Question: Write a single sentence explaining what this figure depicts.
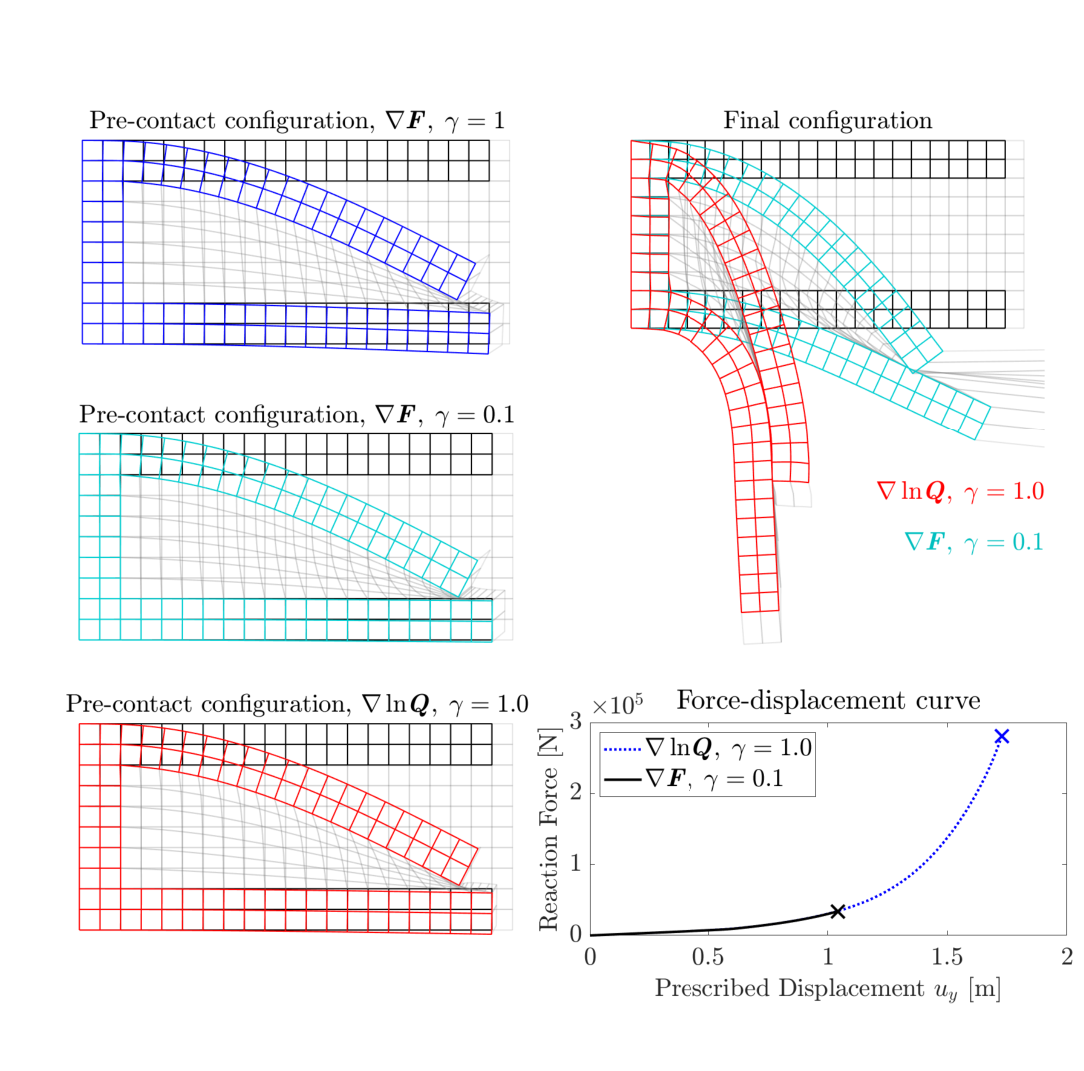
Answer: Self contact example and a comparison of the newly proposed regularization ∇ln Q to a ∇F formulation of Bluhm et al. [30]. In the pre-contact phase, ∇F with γ = 1 exhibits premature contact (in blue), unlike ∇ln Q (in red) or ∇F with γ = 0.1 (in cyan). The final configuration plot and its associated force-displacement curves with highlighted points of failure demonstrate the higher robustness of the ∇ln Q regularization. The ∇ln Q formulation only becomes numerically unstable when the contact surface starts being loaded in a tangential direction.